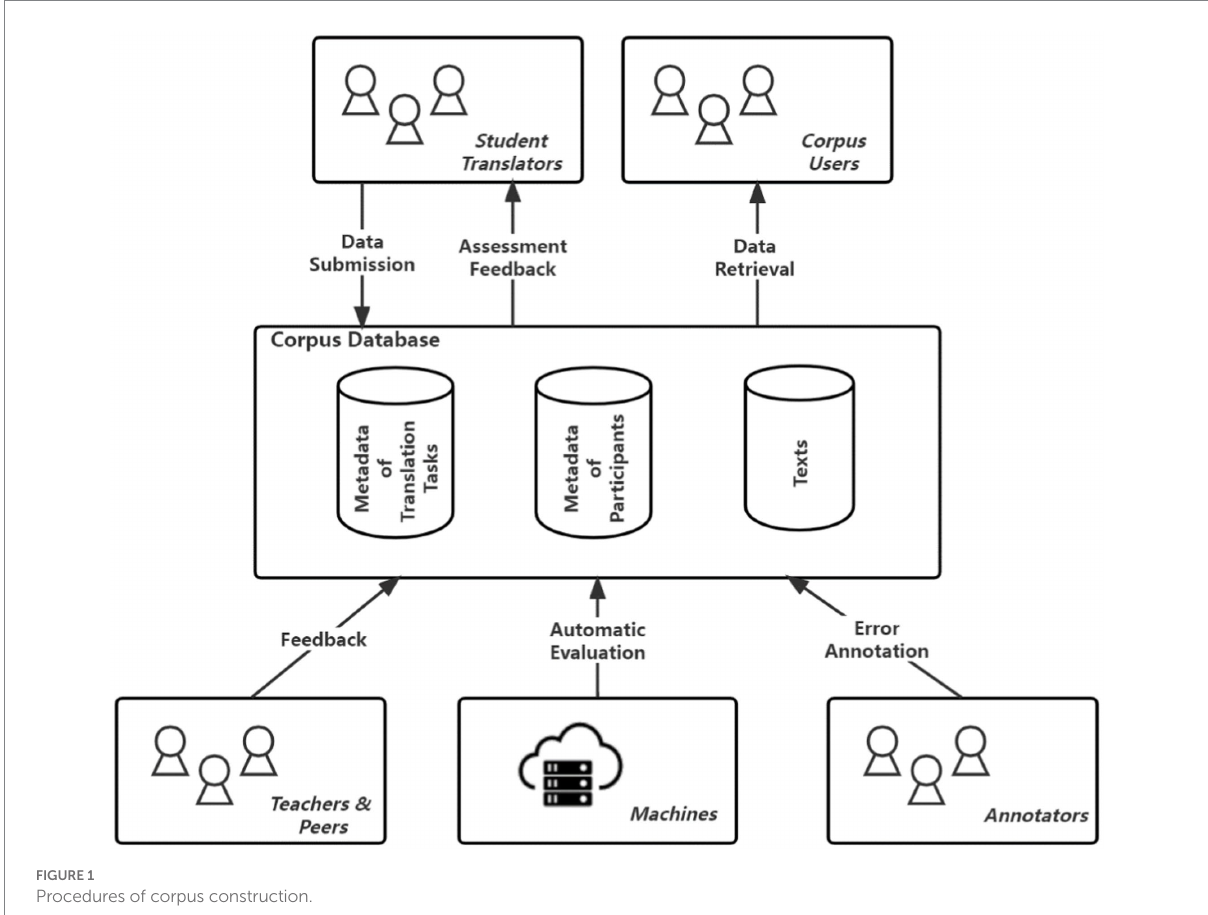
FIGURE 1 Procedures of corpus